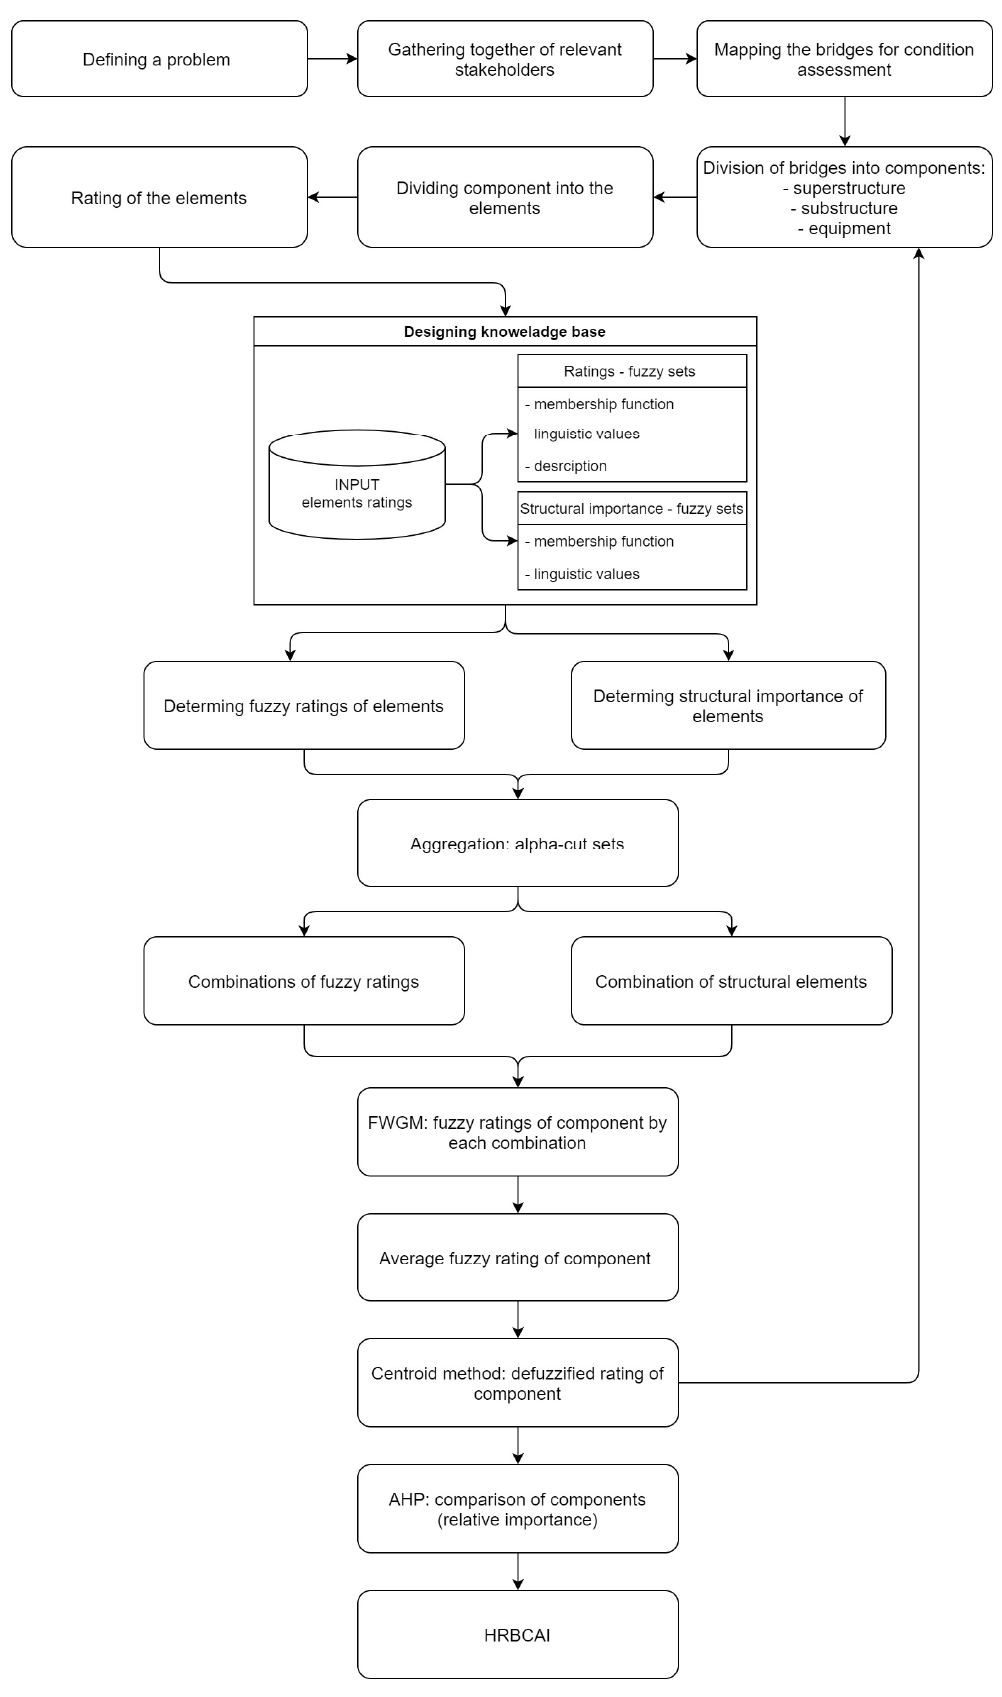
Figure 1. Model to historic road bridge condition rating. Step 1. Assigning a crisp grade to elements ranging from 0 to 100.